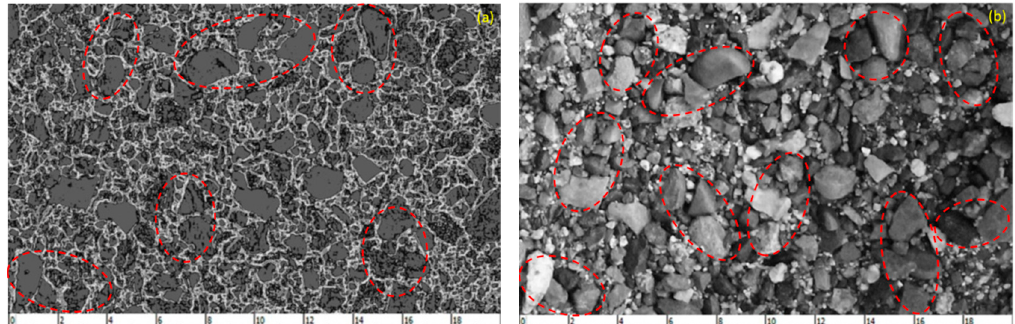
Figure 14. Partially surface morphology of the riverbed after roughening in 21#: ( a ) Projection of the surface of the riverbed (width is 0.2m); ( b ) Actual picture of the riverbed (width is 0.2m).